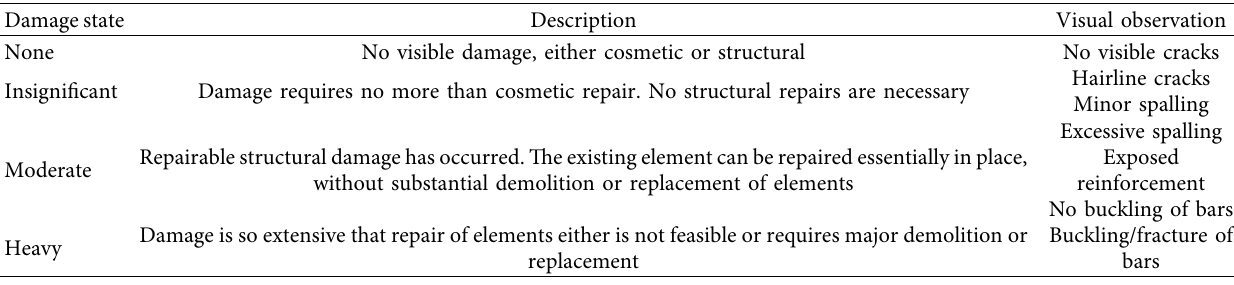
Table 1: Correlation of damage limit states with visual observation [28, 43, 47].